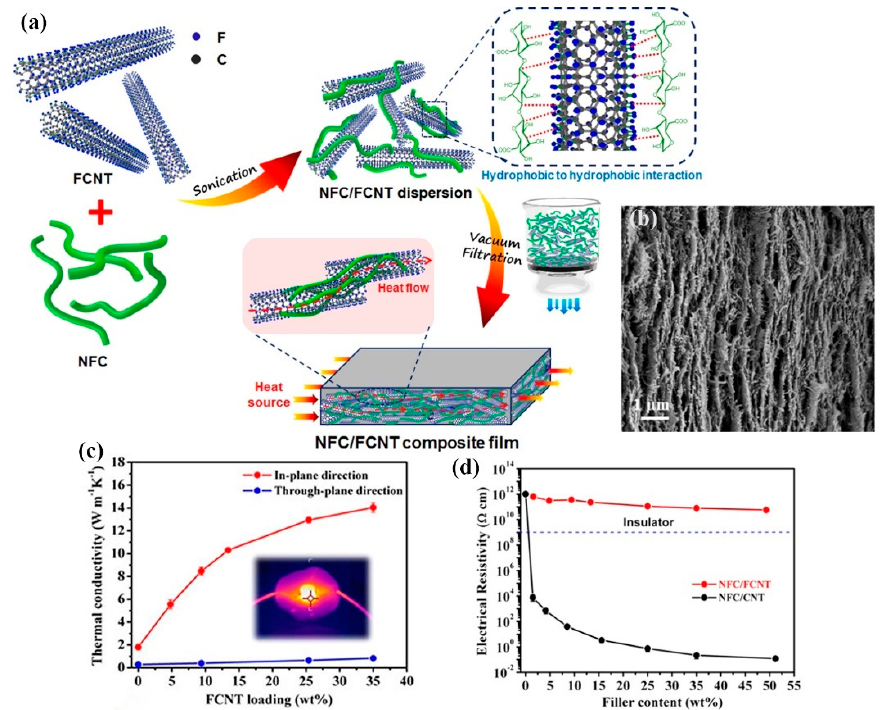
nanocomposites with different nanofillers (reproduced with permission from [124]).